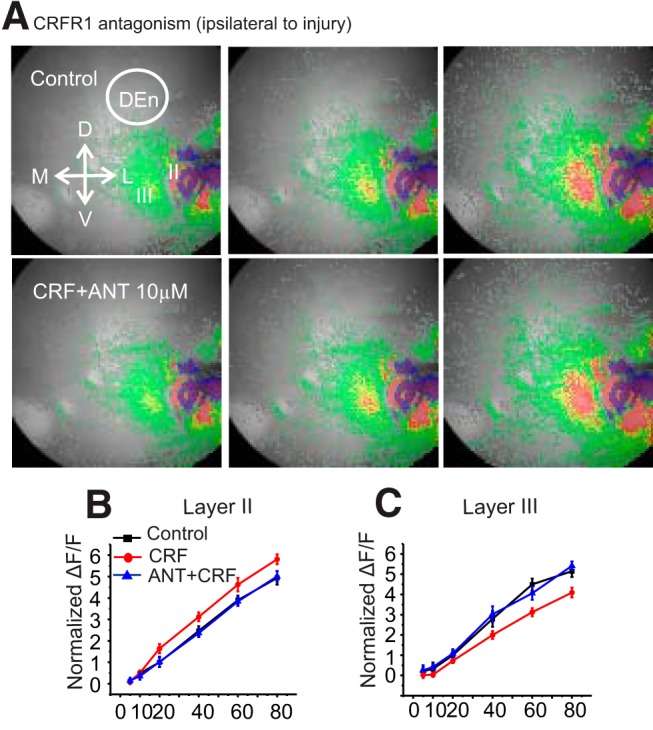
CRFR1 mediate CRF responses in brain-injured PCtx. A, Representative images of the activation of the PCtx layers in slices at differing time points before (top) and after the application of CRF (bottom) in the presence of the CRFR1 antagonist antalarmin. B, C, Quantification of CRFR1 activation in the presence of antalarmin in Layer II and Layer III of ipsilateral PCtx; n = 6 slices from five rats.